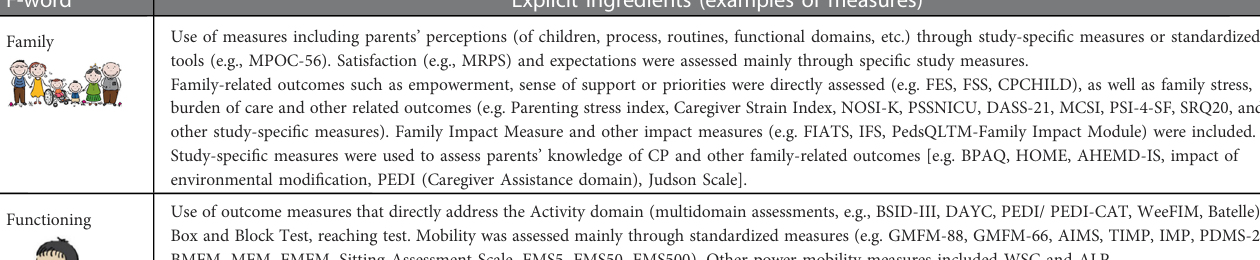
TABLE 2 Explicit ingredients of of the interventions for children with CP GMFCS levels IV and V. F-word Explicit ingredients (examples of measures)